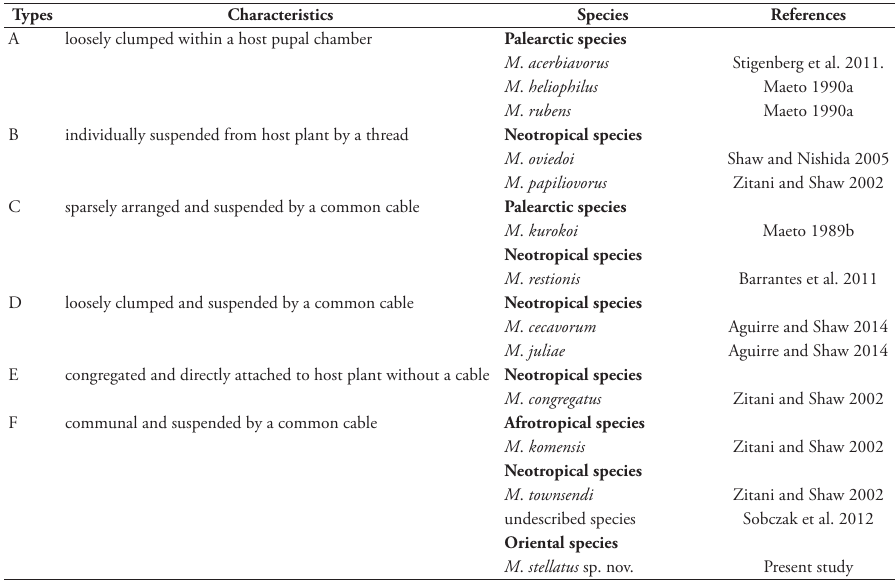
Table 1. The types of cocoon masses in gregarious Meteorus